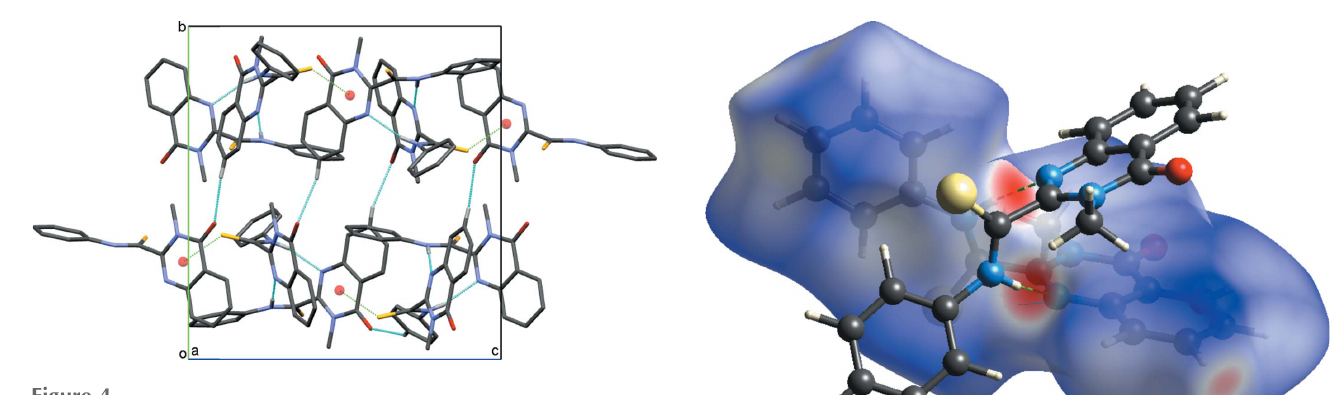
Figure 4 A view of the crystal packing of the title compound along the a axis.